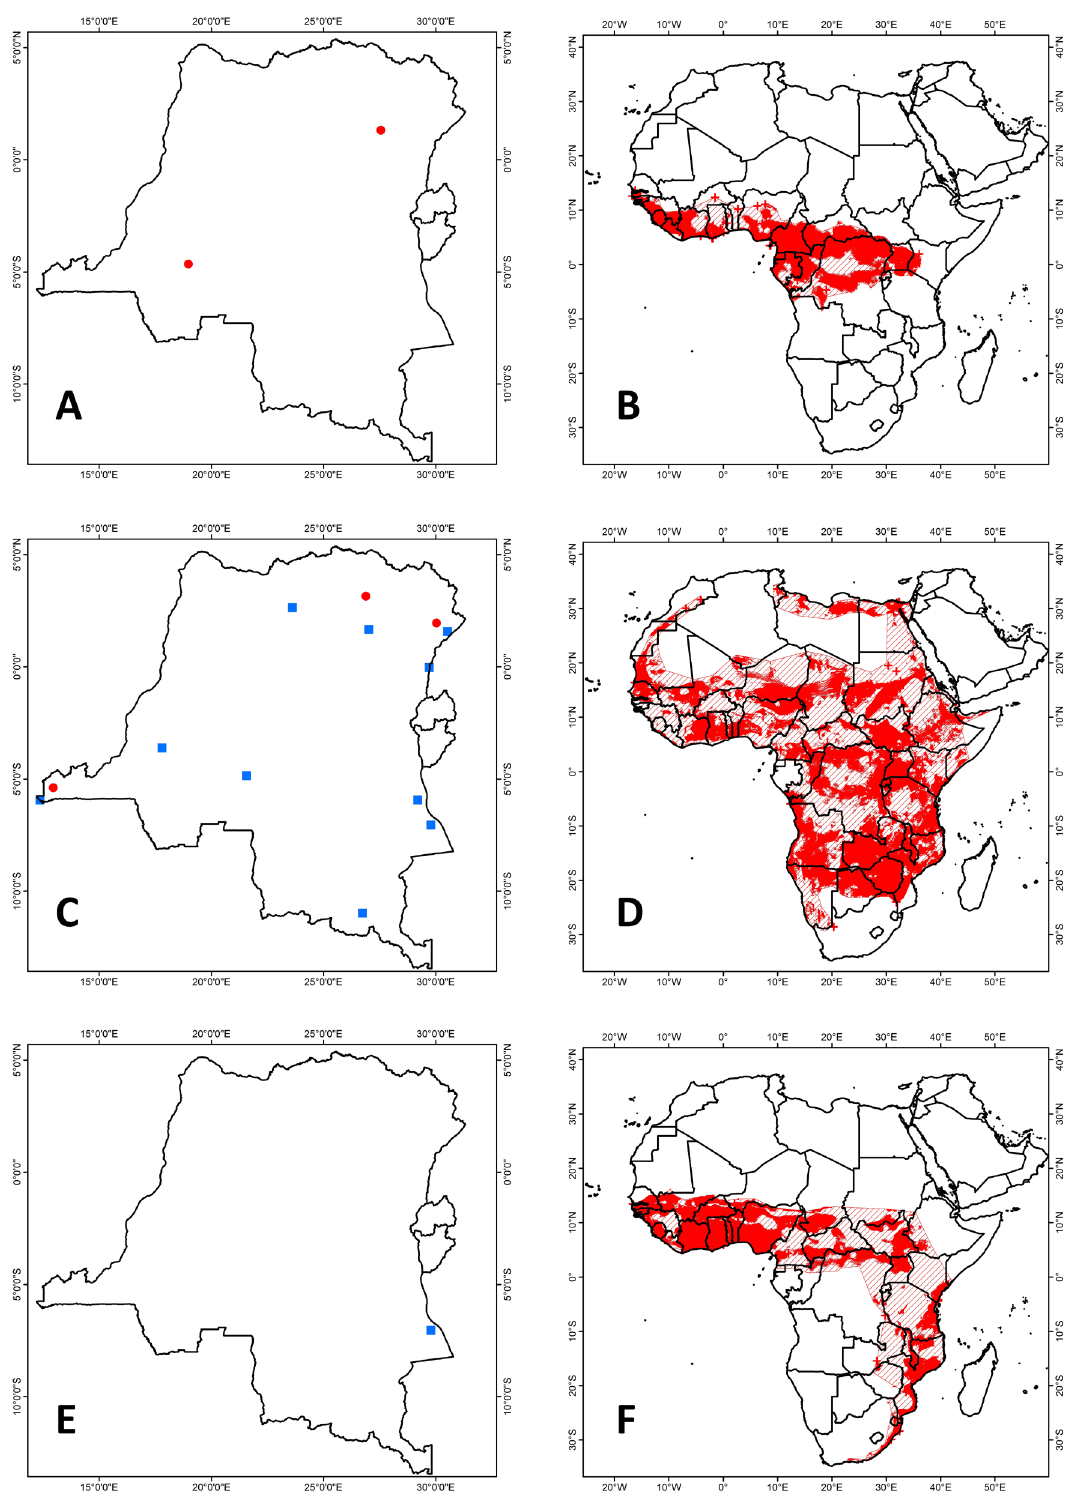
Fig. 47. Distribution maps. A–B . Pipistrellus nanulus Thomas, 1904. C–D . Pipistrellus